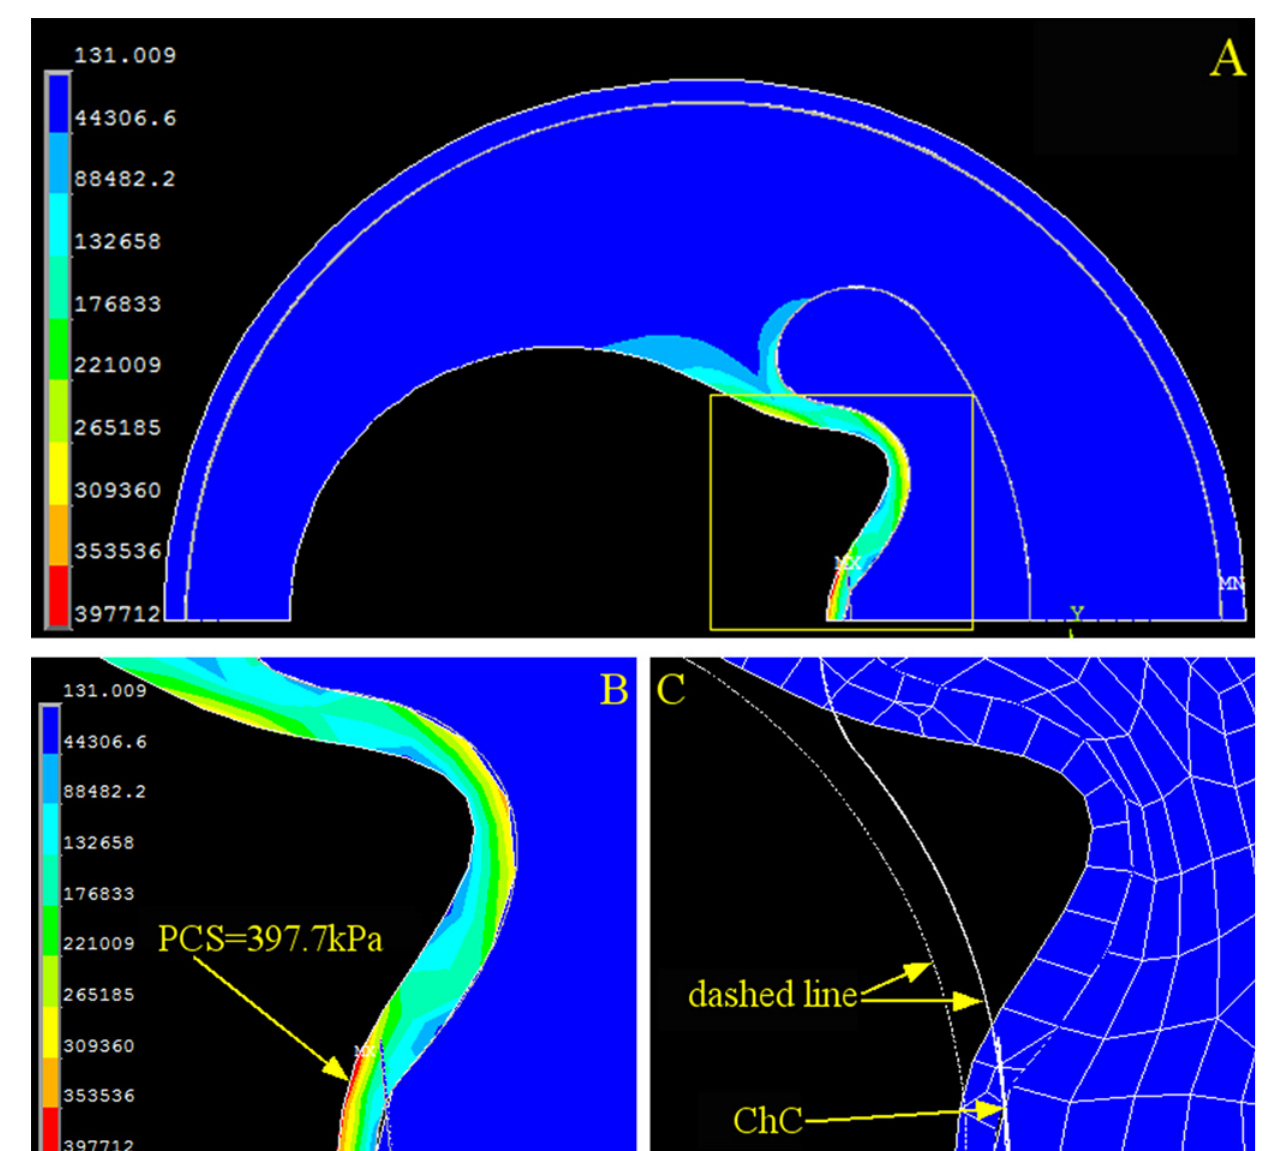
Fig 7. Stress and Strain of the Coronary Artery with One Cholesterol Crystal at the Cap Center. (A) Stress distribution of the overall coronary artery. (B) Contour plot of the stress on the fibrous cap (yellow dashed box in A). (C) Contour plot of the strain on the fibrous cap. The dashed line is the original contour before loading, and the meshed section is the deformed cap after loading. PCS: peak circumferential stress. ChC: cholesterol